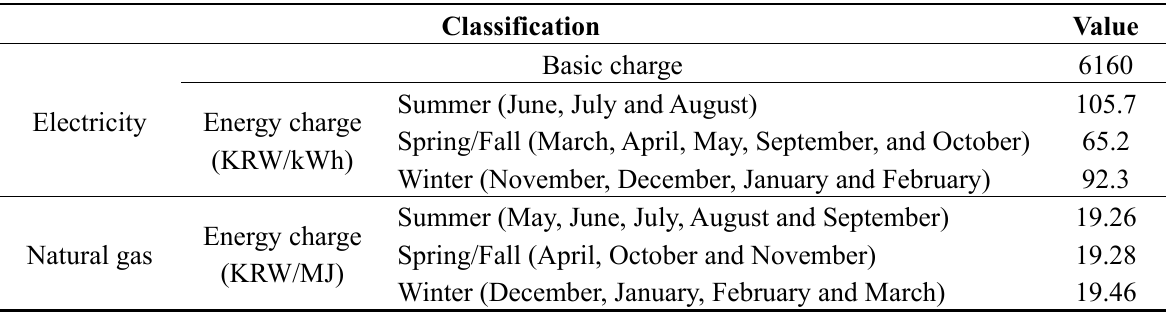
Table 5. Electricity and liquid natural gas